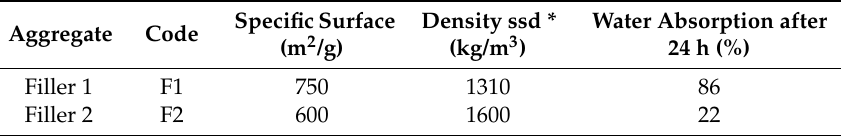
Figure 1. Grain size distribution of fillers. Table 1. Properties of fillers.